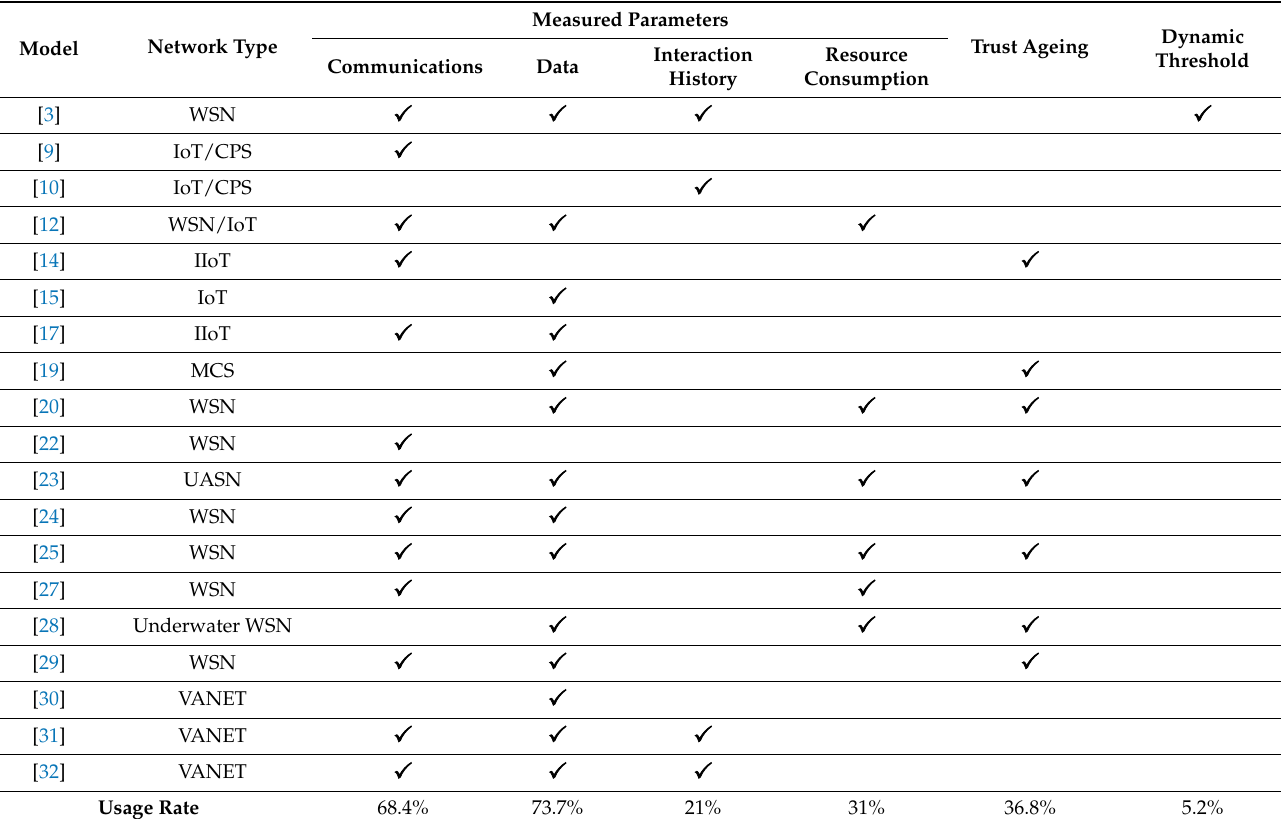
Table 1 . Comparison of the attributes used in trust models.